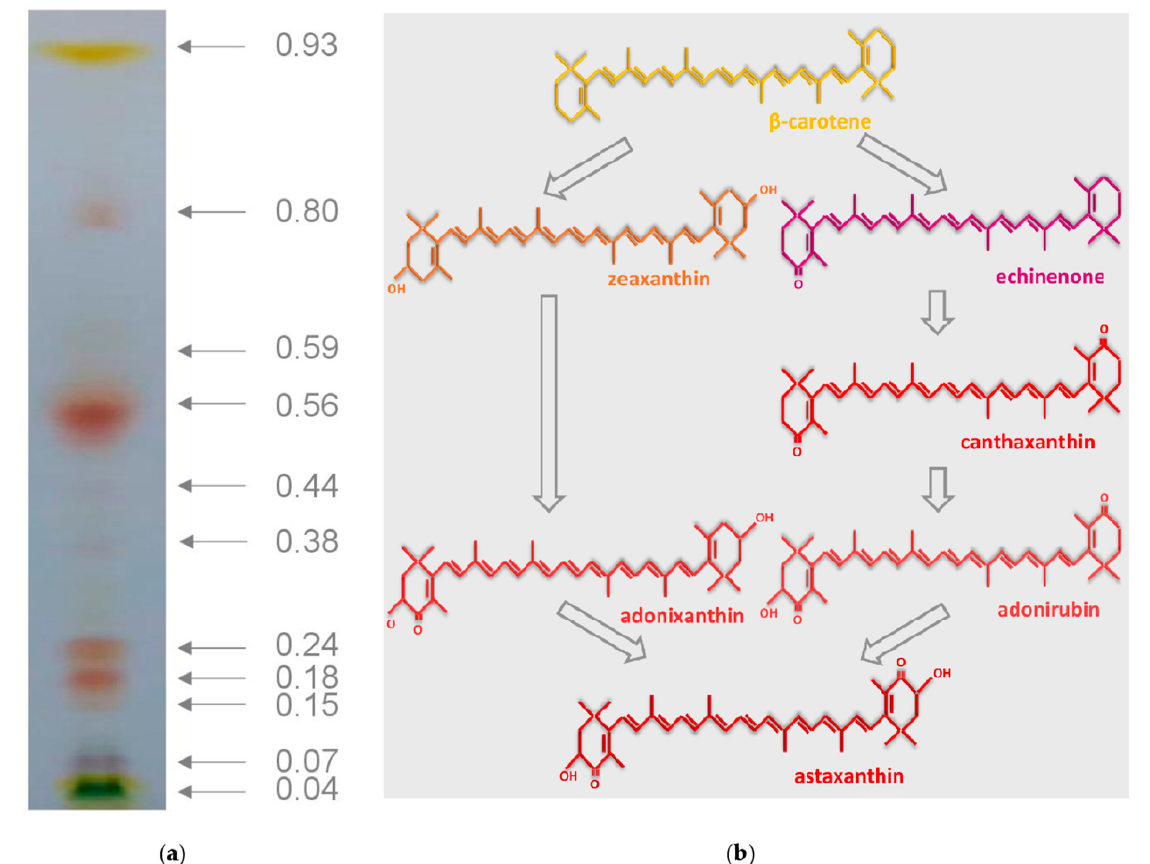
Figure 3. Carotenoid composition of Bracteacoccus aggregatus BM5/15 (IPPAS C-2045) at the inductive stage of cultivation (5th day). ( a ) Representation results of separation of chloroform pigment extracts from the B. aggregatus BM5/15 cells after five days of cultivation under the inductive conditions. Values of the retardation factor are presented for each pigment fraction. ( b ) Putative pathways of xanthophyll synthesis in B. aggregatus BM5/15 based on its pigment profile. Table 2. Fractions of carotenoids obtained after separation of the extracts from the cells of Bracteacoccus aggregatus BM5/15 (IPPAS C-2045) cultivated for five days under the inductive conditions by thin layer chromatography. Values of the retardation factor ( R f ), pigment name based on its R f value and absorbance spectrum, as well as its mass fraction in the total extract are provided. R f Pigment Carotenoid Content (Mas.-% of Other Carotenoids) 0.93 β -carotene